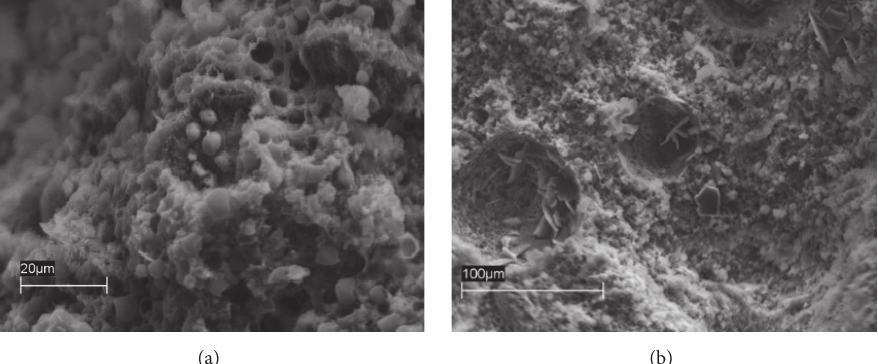
Figure 4: Image at SEM of the mortar with 30% PCM by binder mass (a) and details of cement matrix with high dosage of microcapsules